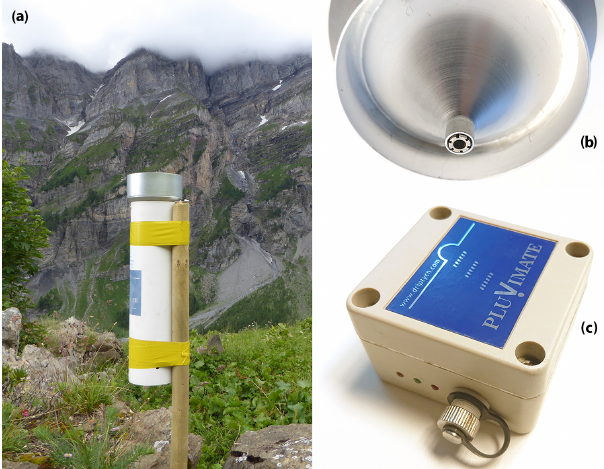
Figure 2. Drop-counting rain gauge used for rainfall measures. The Pluvimate is set up vertically, between 0.8 and 1.2m above the ground level (a) . A tip at the end of the funnel (b) creates a cali- brated drop of water that falls on the sensor, (c) which counts and records the number of drops during a given amount of